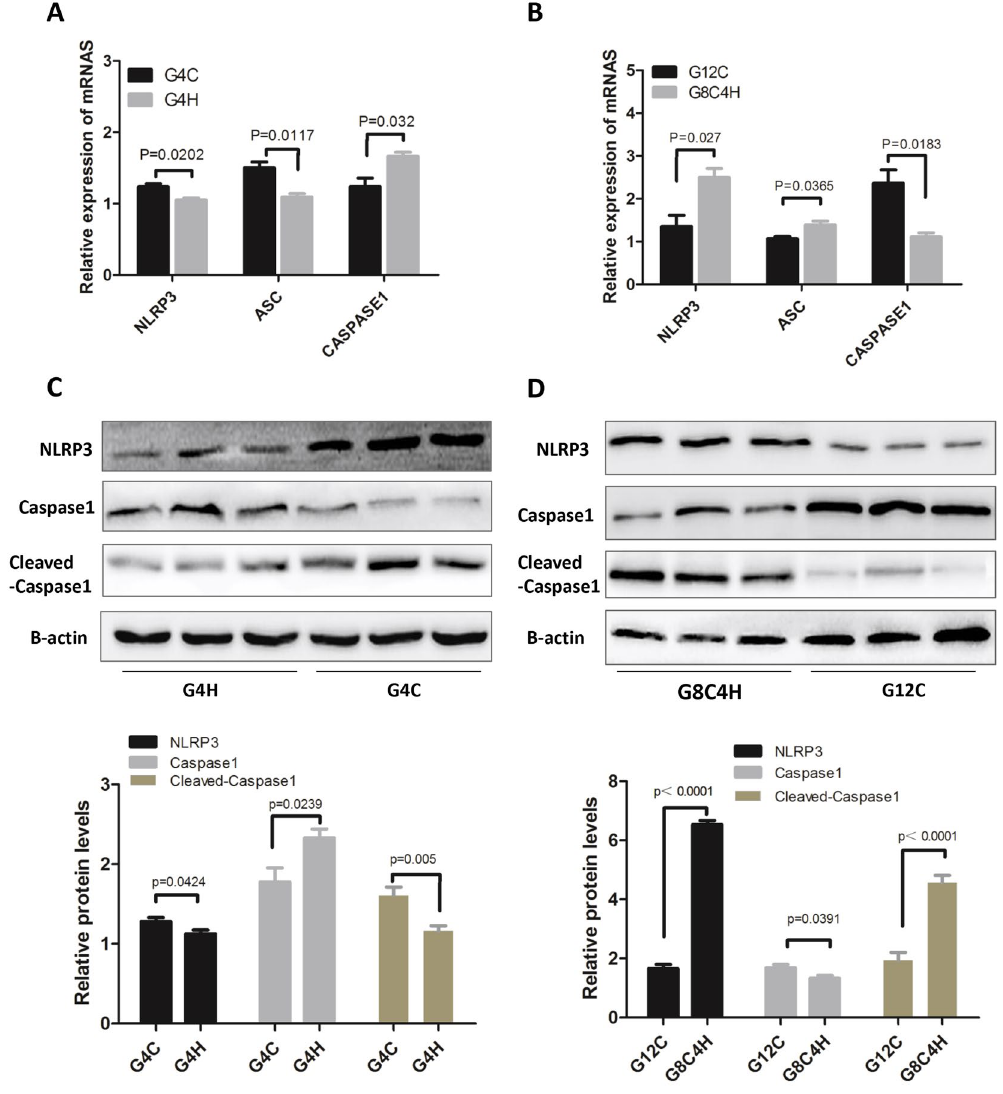
Figure 3. Inflammasome expression in immature and mature mice after fed a HFD. Gene expression of the inflammasome components NLRP3, ASC and caspase-1 were measured in testes using qRT-PCR in G4H and G4C mice ( A ) and in G8C4H and G12C mice ( B ). Total testis protein was extracted from each group: G4H and G4C ( C ), G8C4H and G12C ( D ). Then, western blotting was used to measure the protein expression of NLRP3, caspase-1, cleaved-caspase-1 and β -actin. Western blot analysis of inflammasome-related proteins